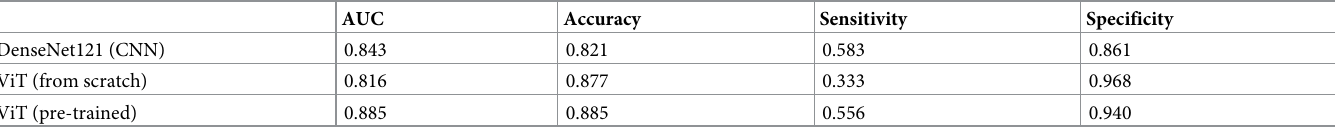
Table 1. Performance of deep learning models for prediction of age � 65 vs. > 65